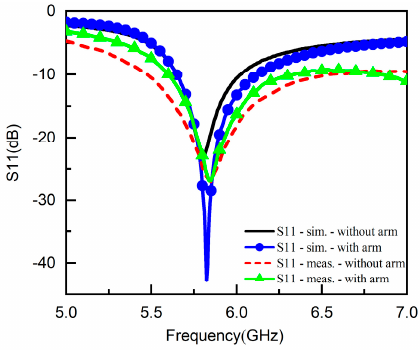
Figure 13. Measured S11s with/without arm.